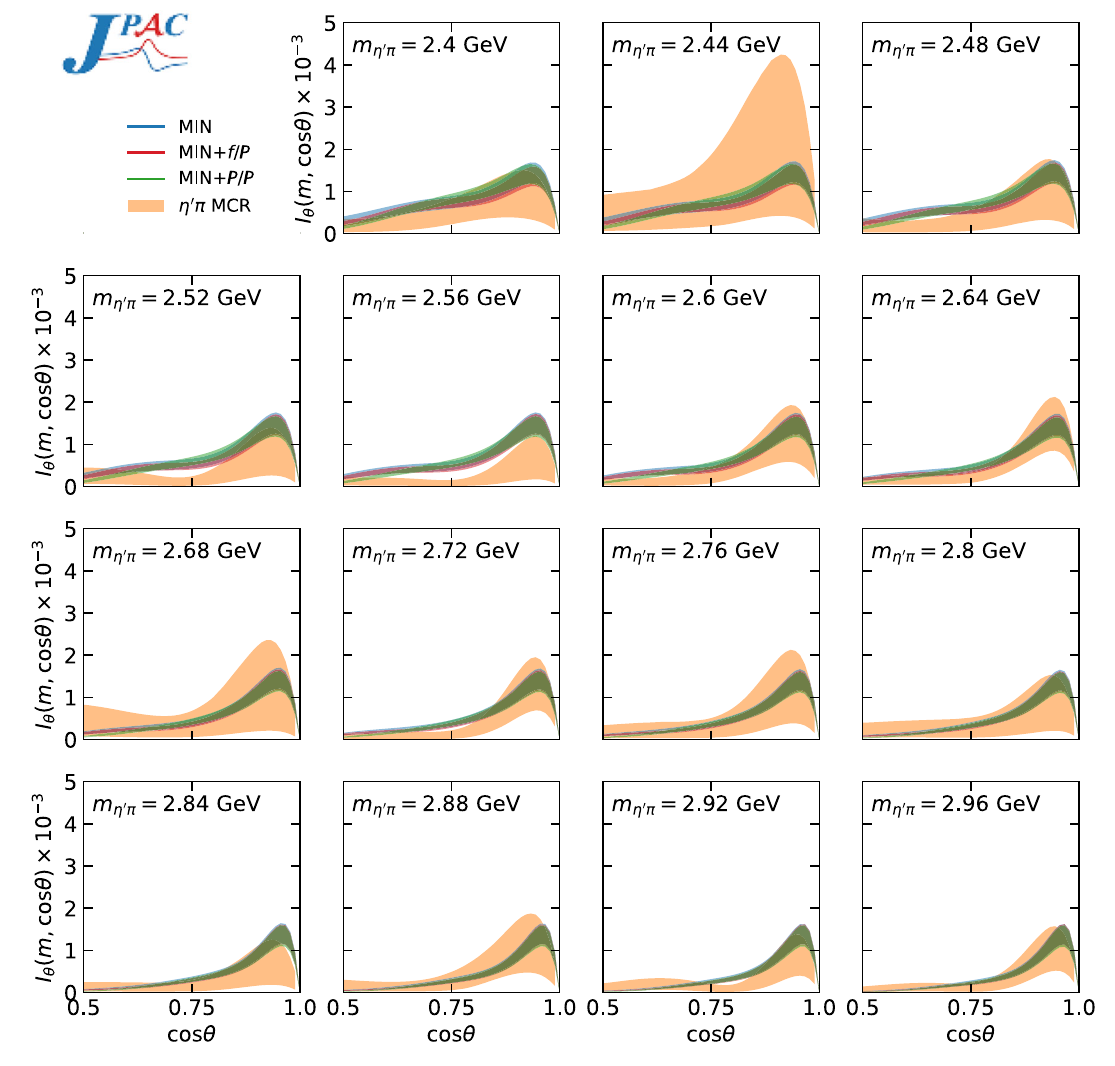
Fig. 16 Same as Fig. 12 for η (cid:2) π